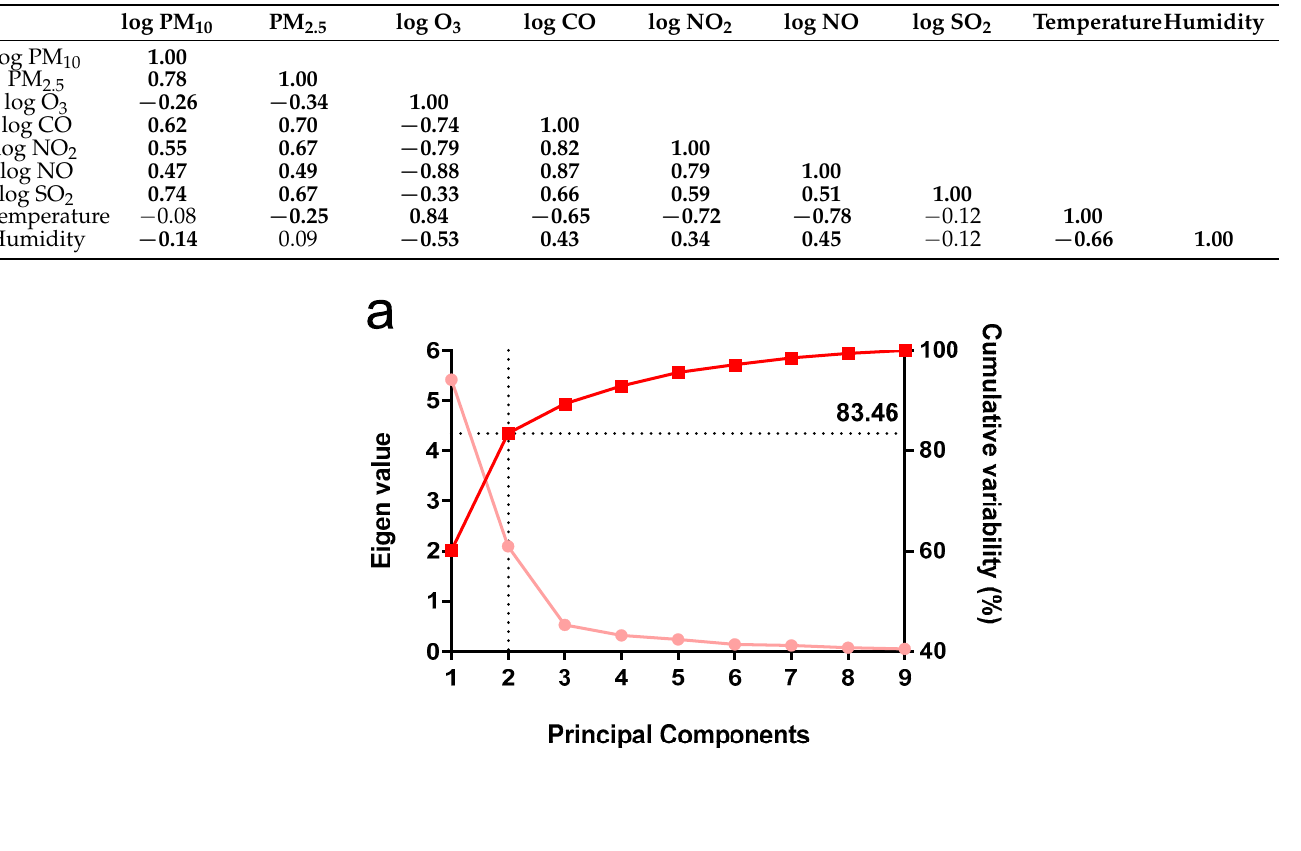
Table 1. Pearson correlation coefficients for temperature, humidity, and pollutant concentration. The values in bold type have a p -value lower than 0.05.